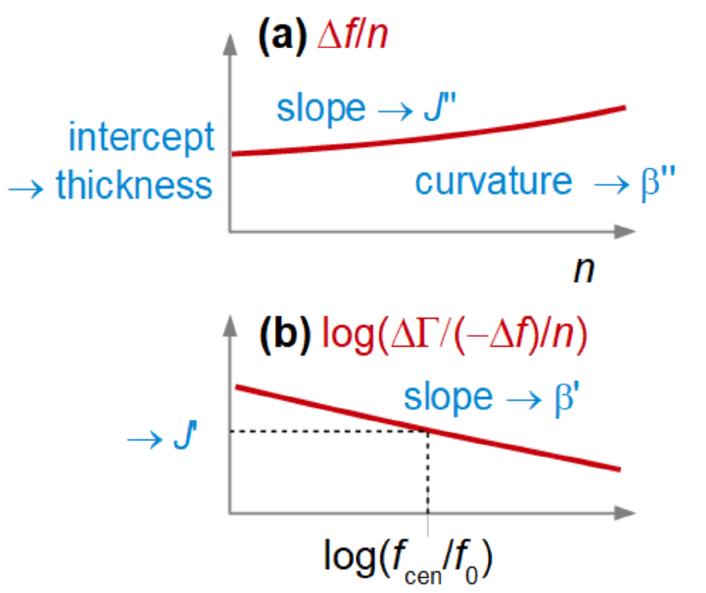
Figure 5. A thin, stiff film in a liquid also allows viscoelastic parameters from the sets of ∆ f / n and ∆Γ / n to be extracted. The plot of ∆ f / n versus n yielded the thickness and the viscous compliance ( a ). The plot of log( ∆Γ /( − ∆ f )/ n ) versus log( n ) yields the elastic compliance and the power-law exponent β (cid:48) ( b ). Arrows indicate which system parameters are derived from certain features of the